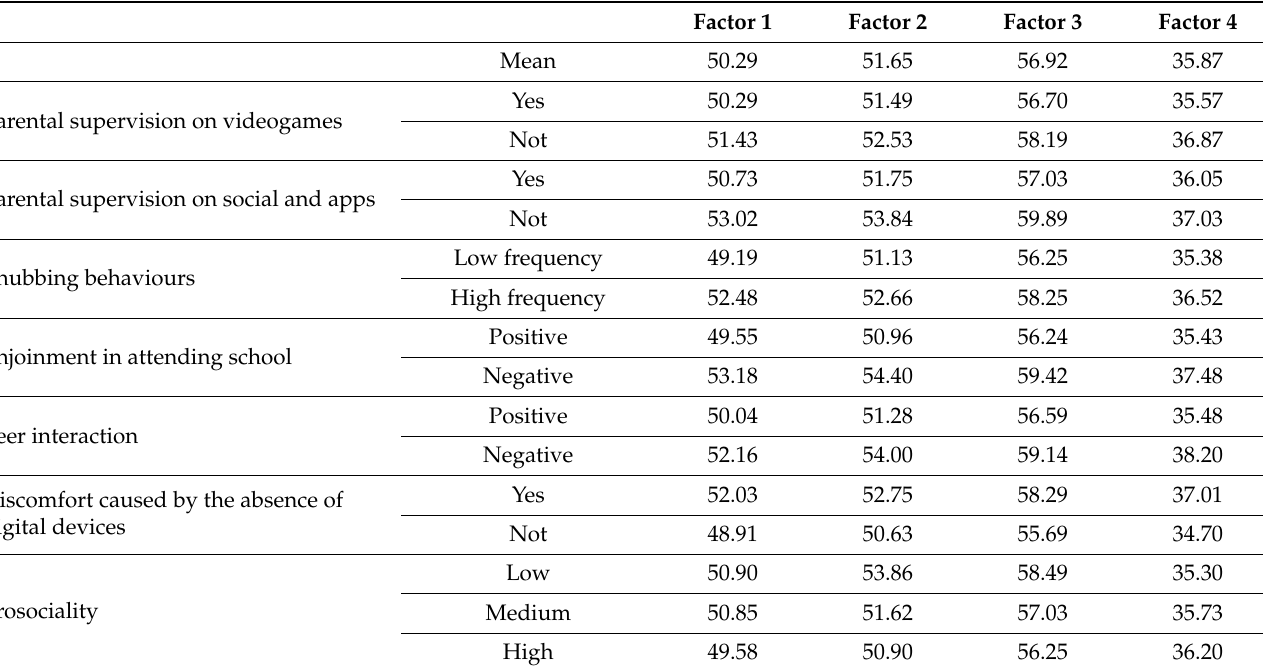
Table 3. Factors’ mean scores for individual and environmental